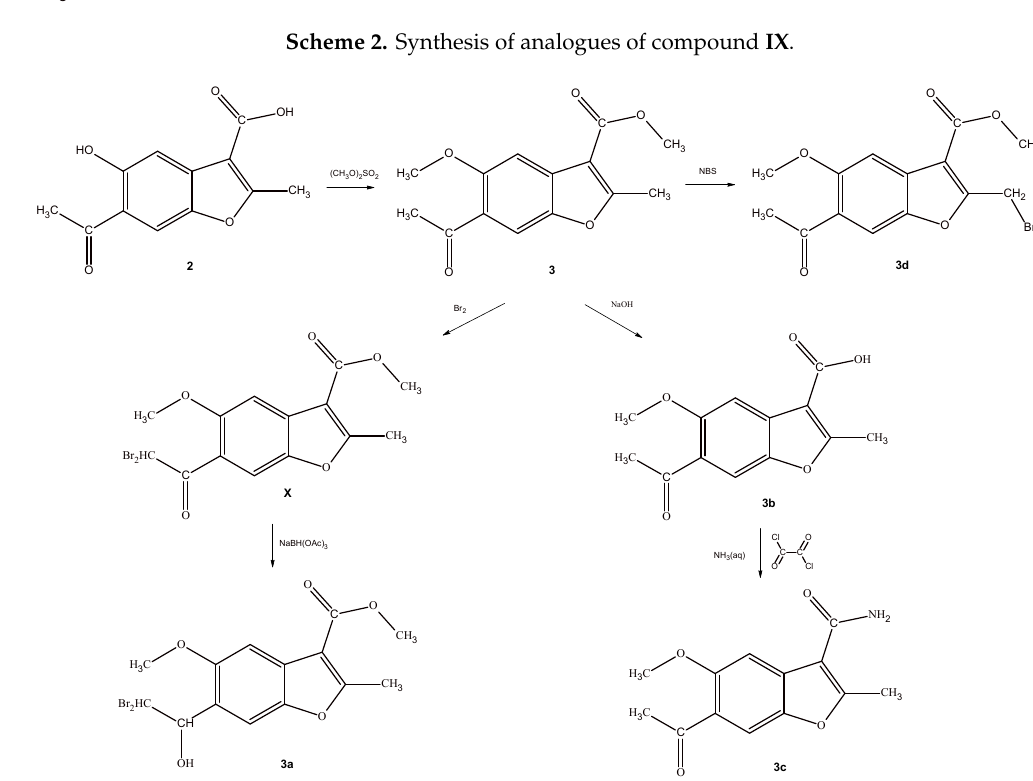
Scheme 3. Synthesis of analogues of compound X . Table 1. Theoretical log P values (clog P ) for obtained compounds calculated by the OSIRIS Property Explorer program .